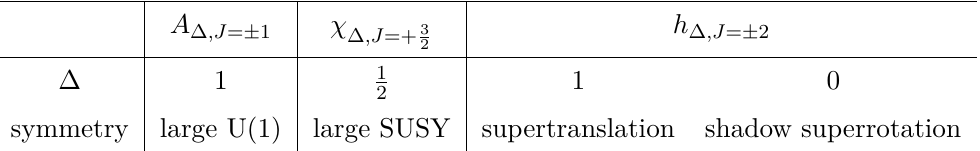
Table 2. Goldstone modes of spontaneously broken asymptotic symmetries for 1 ≤ s ≤ 2 .